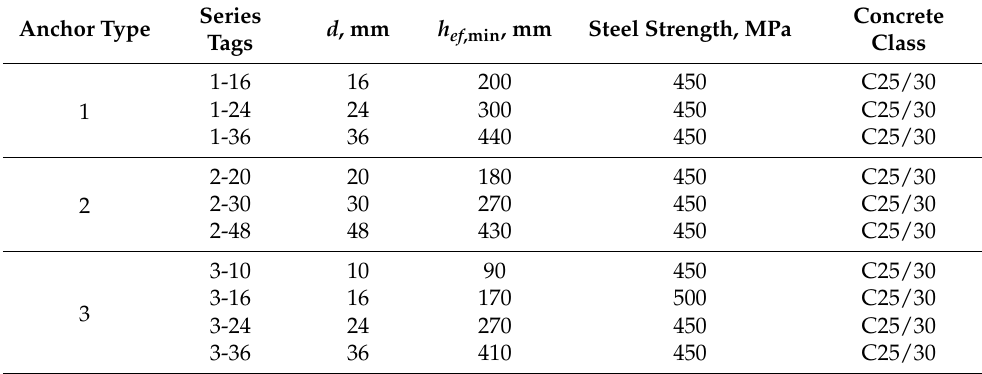
Table 3. Minimum embedment depths ( h ef ,min ) of cast-in-place anchors that trigger the anchor material failure